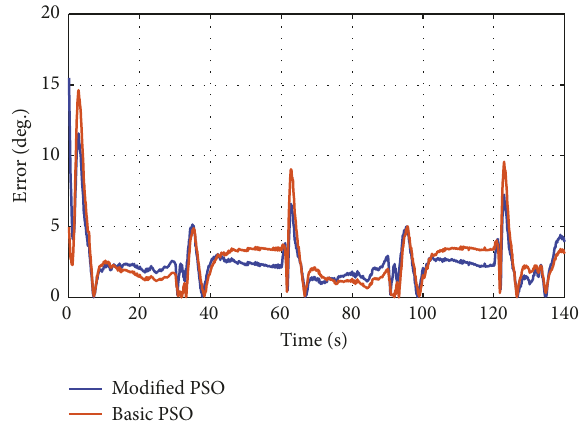
Figure8:ComparisonofmodelingerrorbetweentheJiles-Atherton model with basic PSO algorithm and J-A model with modified PSO algorithm (red line: J-A model with BPSO; blue line: J-A model with